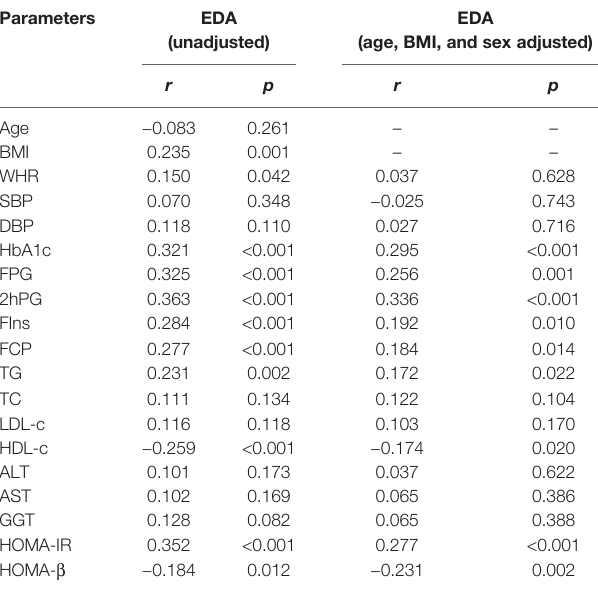
TABLE 4 | Partial correlations analysis of variables associated with serum Ectodysplasin A levels in study population. Parameters EDA (unadjusted)